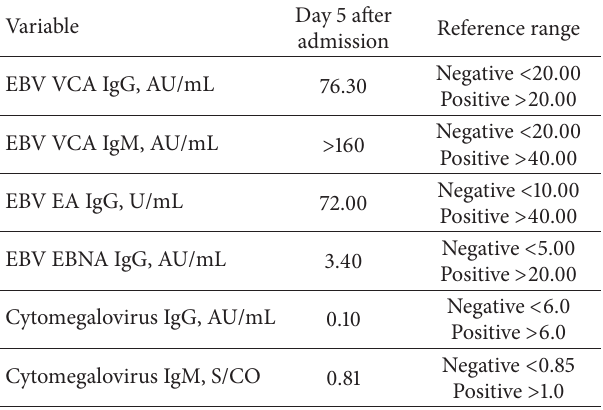
Table 2: Laboratory